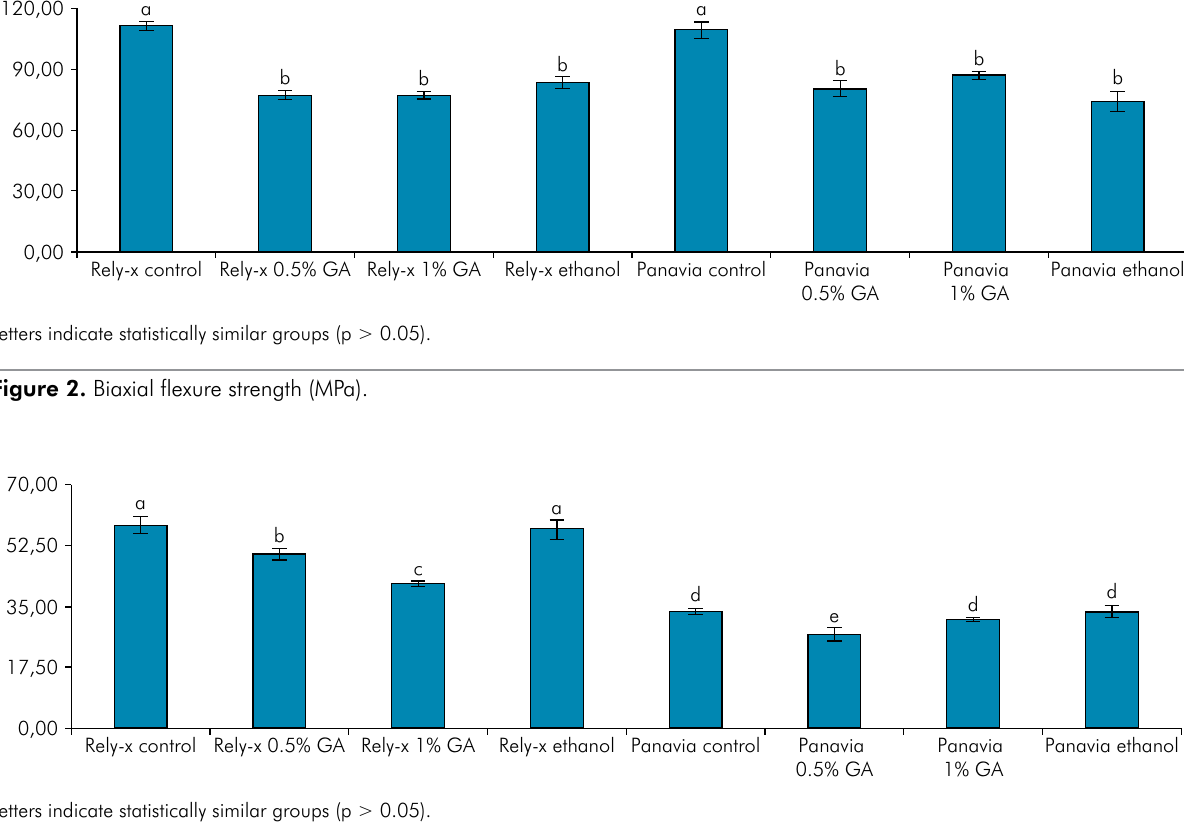
Figure 3. Vickers’